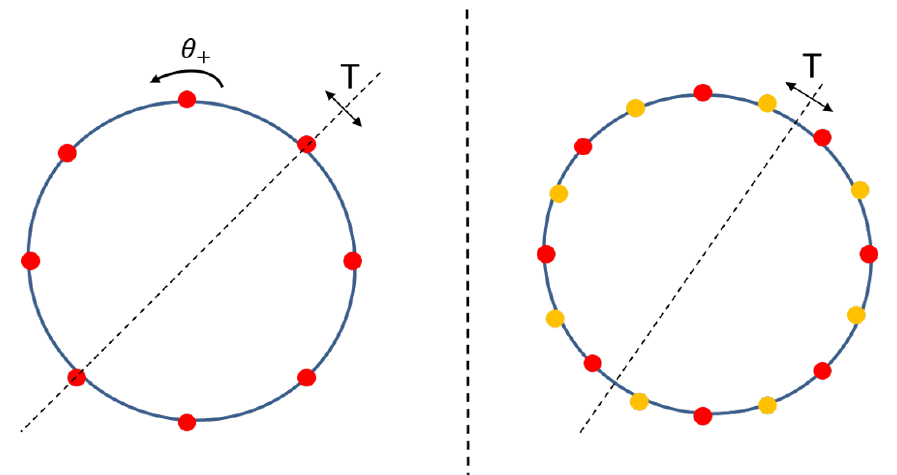
Figure 5 . On the left, the vacuum structure at ( (cid:18) 1 ; (cid:18) 2 ) = (0 ; 0). The red dots are located at (cid:11) k = 2 (cid:25)k with integer k . They represent the vacua with N these vacua, there is a combination of T and chiral symmetry that acts as re(cid:13)ection around the corresponding dot and hence preserved by the vacuum. On the right, the vacuum structure at ( (cid:18) 1 ; (cid:18) 2 ) = ( (cid:25)= 2 ; (cid:0) (cid:25)= 2). Here, combinations of T and chiral symmetry act as re(cid:13)ection between the dots and are broken by the vacuum. The yellow dots are new vacua located at (cid:11) k = 2 (cid:25)k half-integer k and their existence is due to the spontanous breaking of T